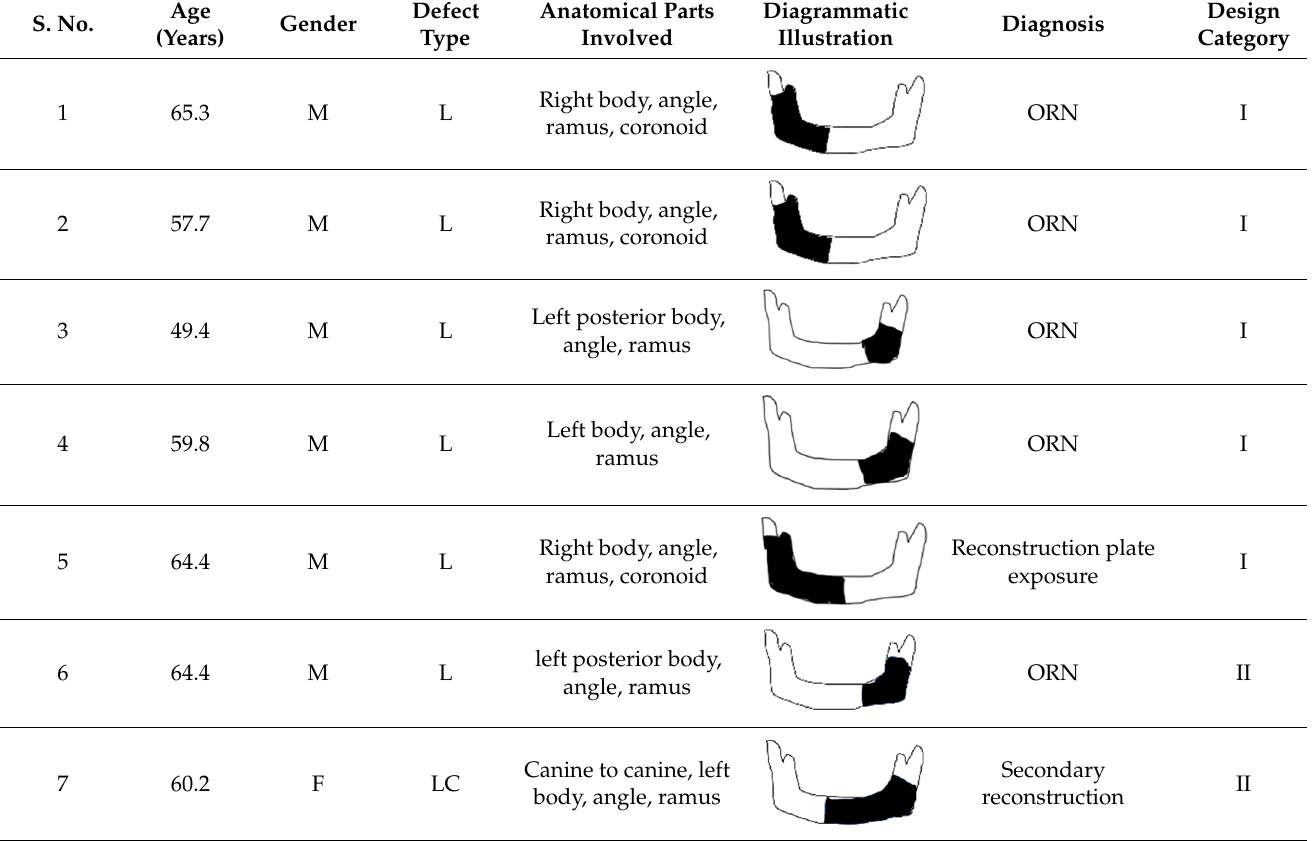
Table 1. Demographic and clinical details of the patients included in the study. Abbreviations: L, lateral; LC, lateral/central; LCL, lateral/central/lateral; ORN, osteoradionecrosis. S. No.